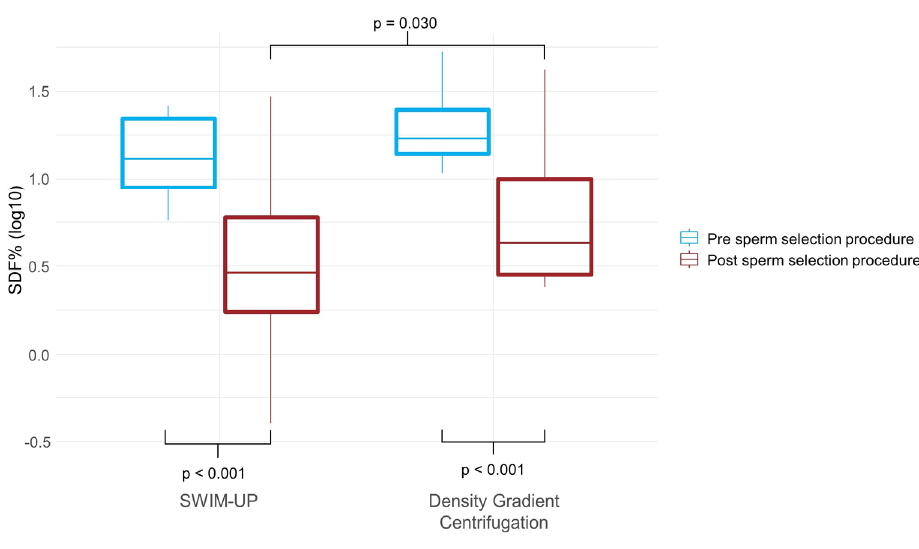
Figure 1. Comparison of SDF% before and after sperm selection procedures by DGC and SW. Table 3. Spearman correlations between SDF with seminal characteristic: ( a ) pre sperm selection procedures; ( b ) post sperm selection procedures.